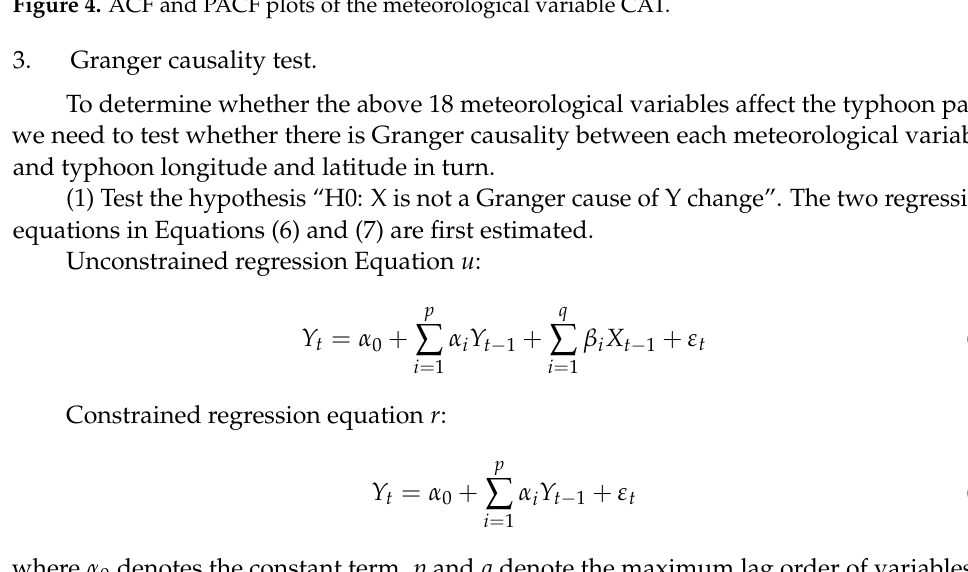
Figure 4. ACF and PACF plots of the meteorological variable